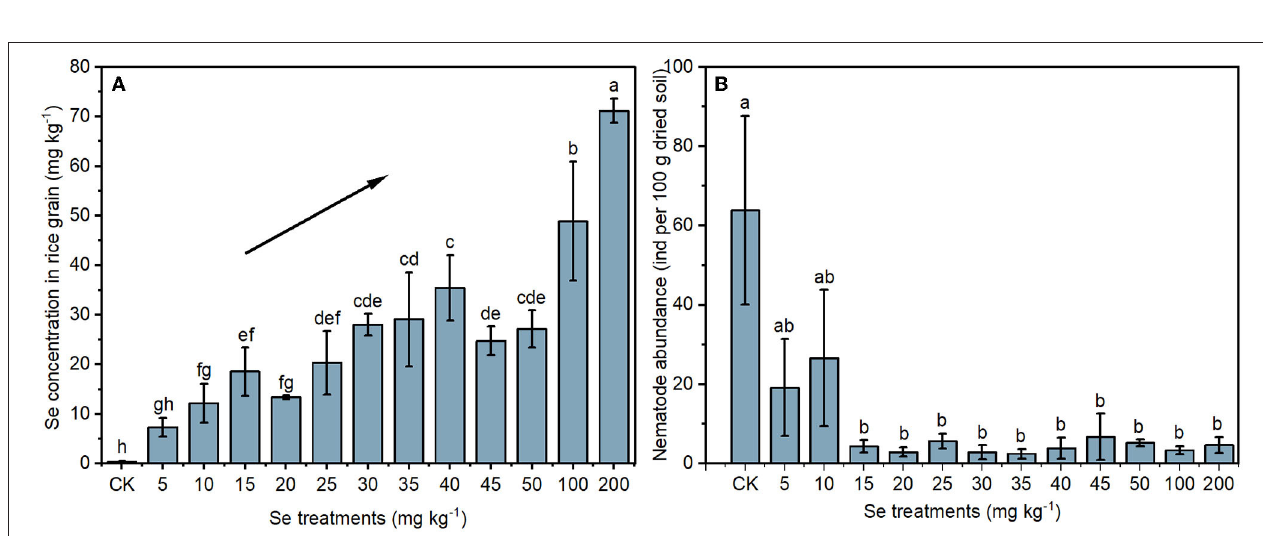
FIGURE 2 | Selenium concentrations in rice grains (A) and the abundance of nematodes in soil (B) under different Se treatments. The black line with an arrow indicates an increasing trend. Values represent mean ± SD. Any two samples within a bar chart sharing a common letter are not significantly different at the p < 0.05